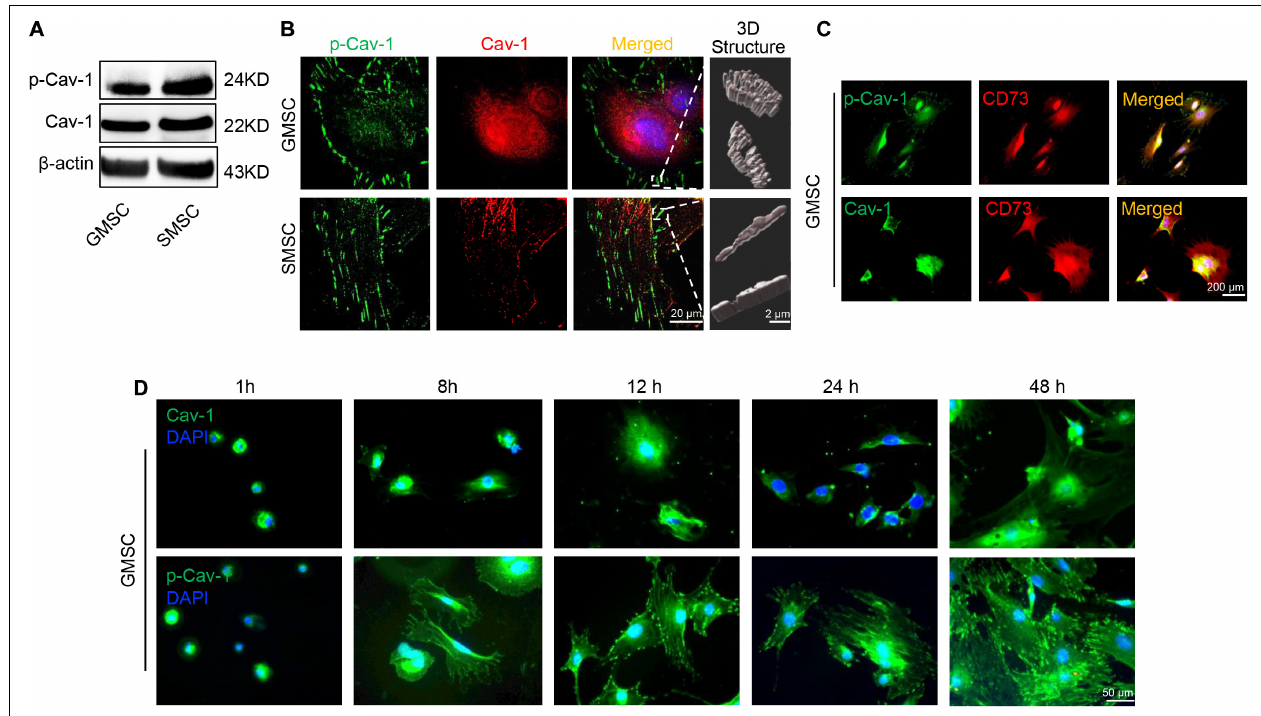
FIGURE 2 | Murine GMSCs displayed lower Cav-1 phosphorylation than SMSCs. (A) Western blotting analysis showed the expression of p-Cav-1 and Cav-1 in GMSCs and SMSCs. (B) Higher resolution images of Cav-1 (red) and p-Cav-1 (green) in MSCs captured by SIM microscopy. Scale bar, 20 µ m. Right panel, 3D reconstruction of 2D Z -stack data showed the different steric structures of p-Cav-1 in GMSCs and SMSCs. Scale bar, 2 µ m. (C) Immunofluorescence analysis showed that p-Cav-1 or Cav-1 (green) co-localized with the MSC marker CD73 (red) in GMSCs. Scale bar, 200 µ m. (D) Representative immunofluorescence staining images of p-Cav-1 and Cav-1 (green) in GMSCs at indicated time point after seeding to the culture plate. Time dependent p-Cav-1 translocation could be observed. Scale bar, 50 µ